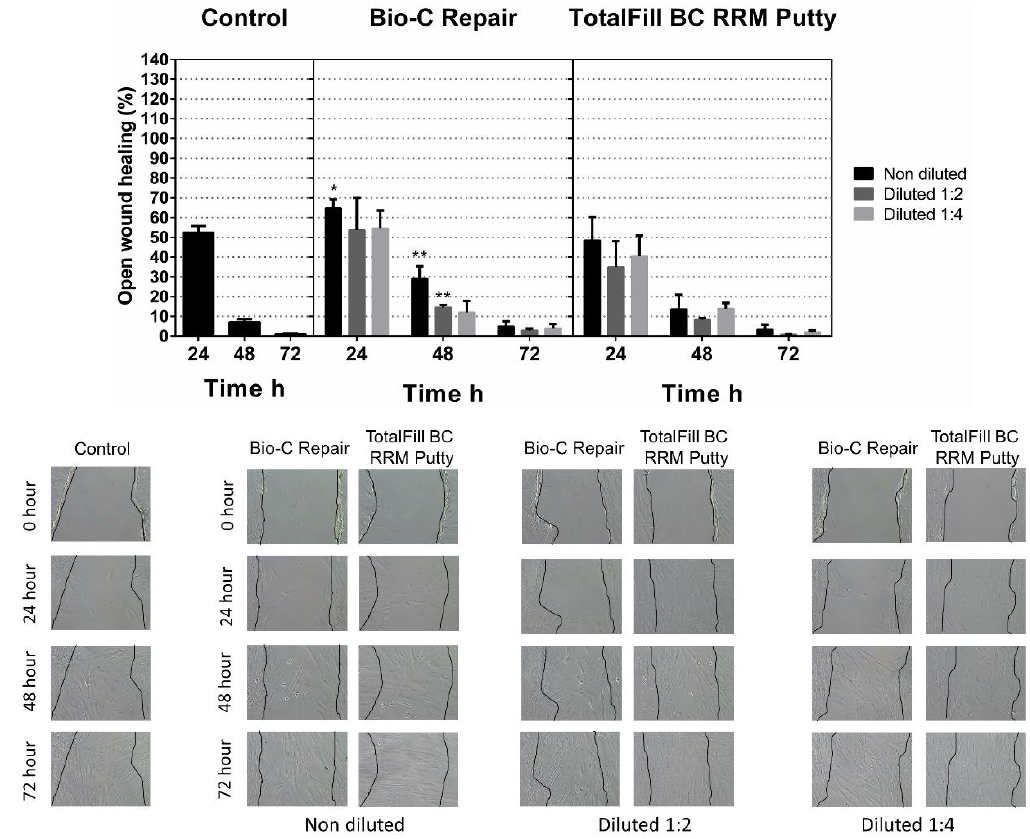
Figure 3. In vitro scratch migration assay. The wound closure was evaluated at 24 h, 48 h, and 72 h, in the presence of different material extracts, or without extracts (control group). Data are expressed as fold of the control group (considered as 100%). Cell migration differences are shown as * p < 0.005, ** p < 0.01, and *** p < 0.001.